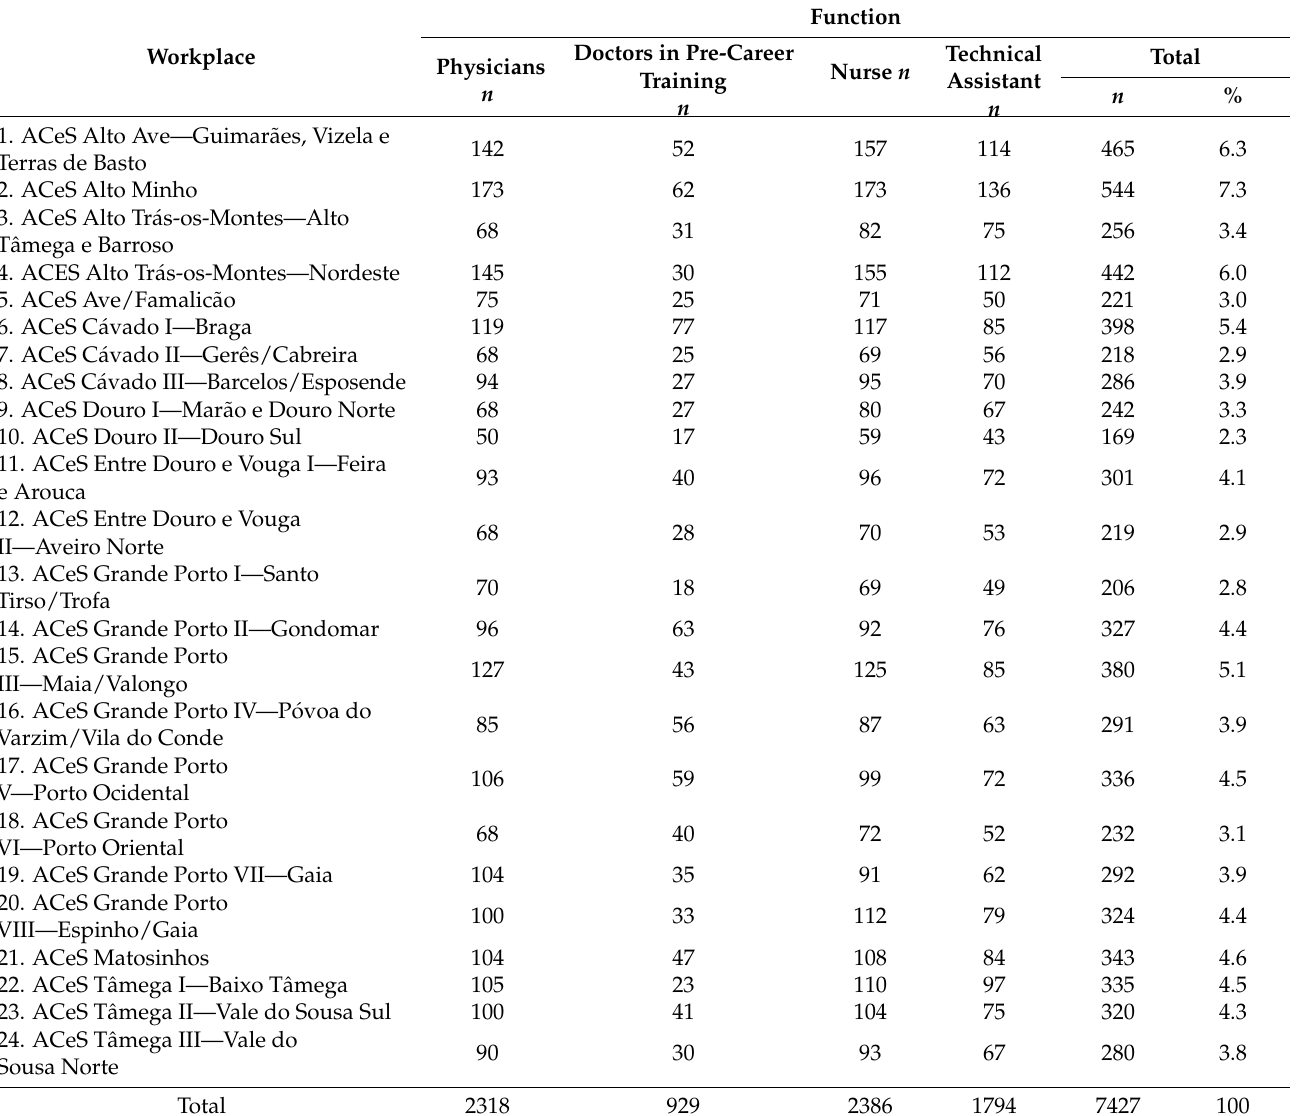
Table A1. Descriptive analysis of the population ( workplace and function ). (Bi-CSP ® : bicsp.min- saude.pt, accessed on 31 January